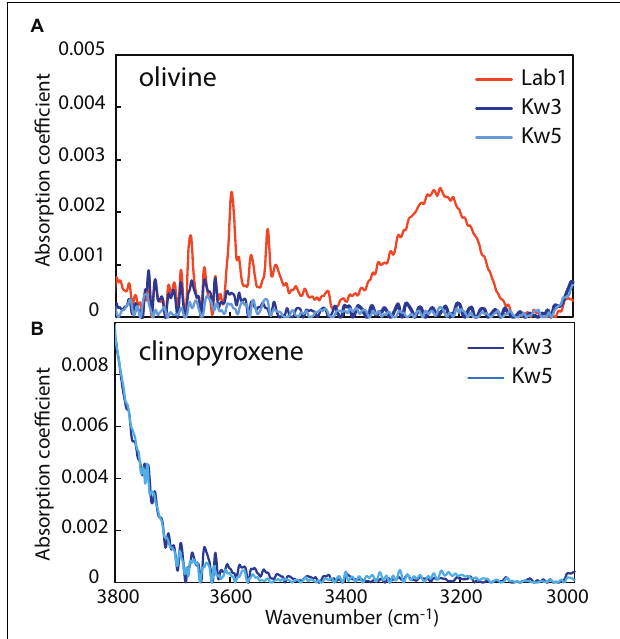
FIGURE 5 | Representative FTIR spectra of unoriented (A) olivine (4 ppm H 2 O for Lab1 and < 1 ppm H 2 O for Kw3, Kw5) and (B) clinopyroxene ( < 1